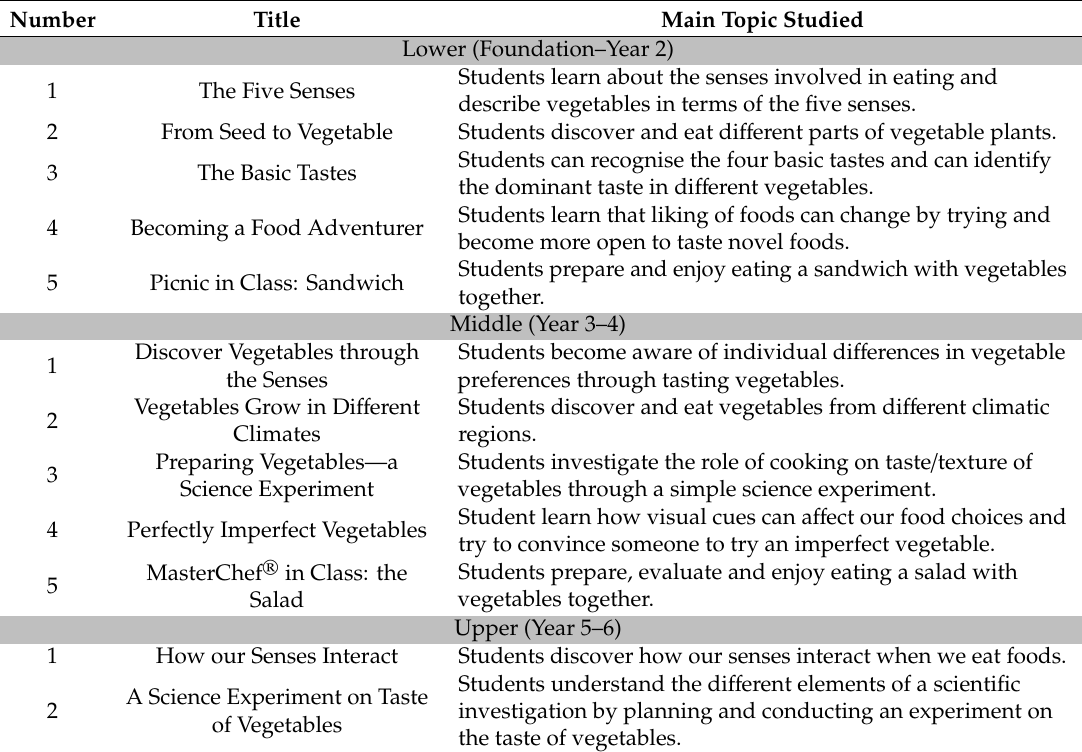
Table A1. Outline of curricula lesson topics of Vegetable Education Resource To Increase Children’s Acceptance and